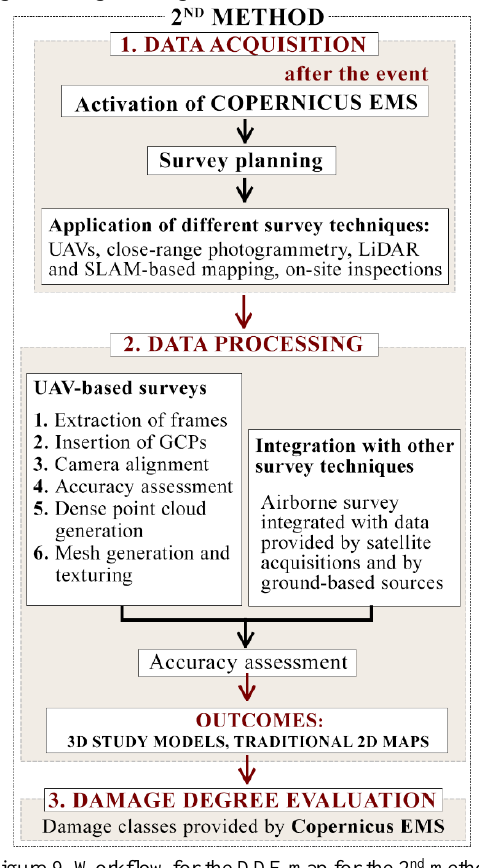
Figure 9. Workflow for the DDE map for the 2 nd method.